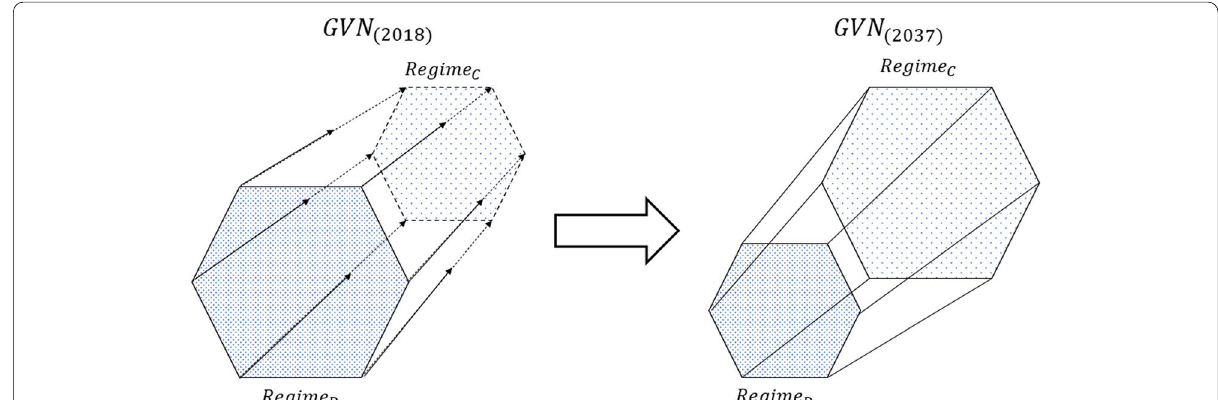
Fig. 1 Socio-technical transformation of a GVN (prism shape) involves a shifting balance between the two co-existing RTI regimes as time goes by; the dominant regime (front end) diminishes as the challenger regime (depicted with a dashed line in the back end in 2018) gains ground. Each edge depicts a different change in the regime, such as a change in technology, politics, industry and culture. Compare with the three waves of Alvin Toffler